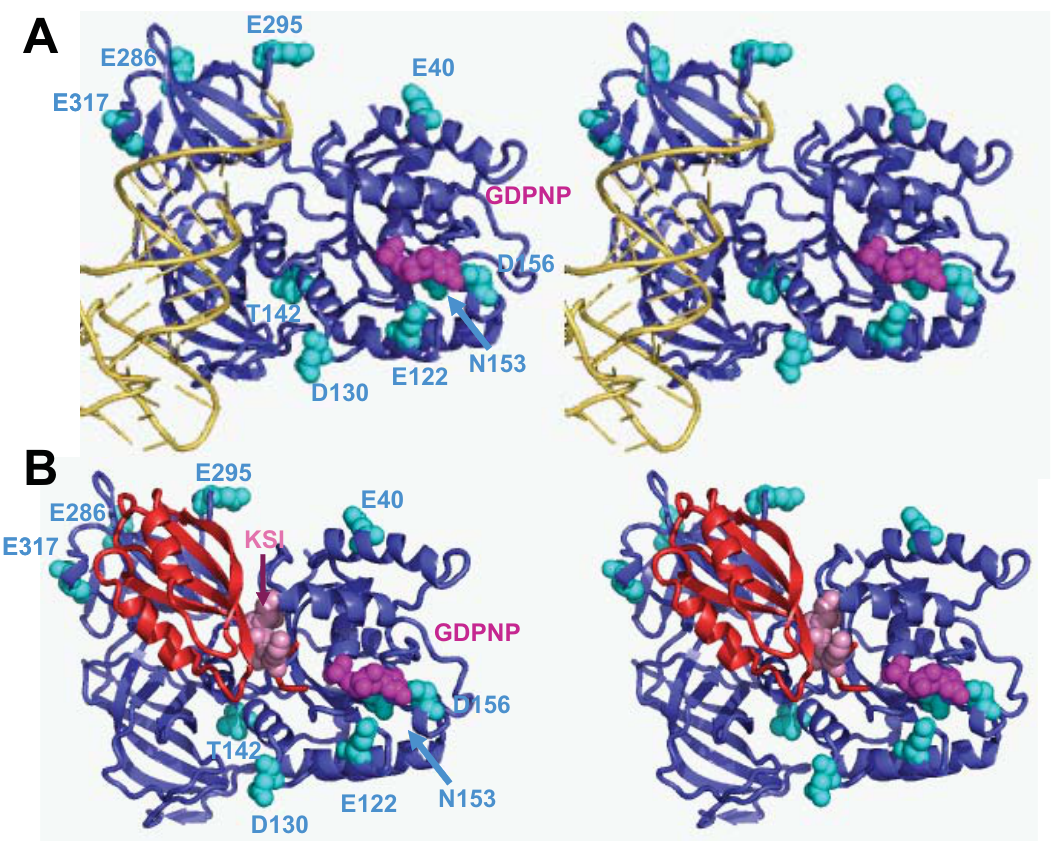
Figure 5. Modeling of mutations in eEF1A and eEF1B a that influence influence misincorporation of missense aa-tRNAs. The nucleotide exchange factor eEF1B a and the fitted aa-tRNA present clashes indicating that they do not interact with eEF1A simultaneously. PyMOL (Delano Scientific, LLC) was used with the coordinates 1G7C of yeast eEF1A:eEF1B a (amino acids 114–206) in complex with GDPNP [50]. The ribbon structure of eEF1A is shown in blue, eEF1A mutated bases are shown in cyan, and GDPNP is indicated in magenta. Panel A. tRNA (yellow) was fitted into the structure based on coordinates obtained from the crystal structure of the EF-Tu:Phe-tRNA Phe :GCPNP complex (1TTT in the RSCN Protein Data Bank, [51]. Panel B. Ribbon structure of eEF1B a from 1G7C is shown in red, and the KSI residues in the mutant form used in this study are indicated in salmon.